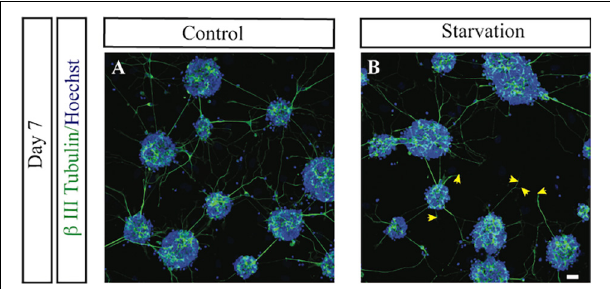
FIGURE 2 | The impact of exposure to starvation for glucose on neurite outgrowth in embryonic retinal cells. Representative confocal LSM images of untreated (control) (A) and starved primary retinal cells (B) on day 7 of the experiment described in this figure, showing neurons ( β III tubulin) and cell nuclei (Hoechst). The images are representative of 3–4 replicates. Scale bar, 20 µ m. n = 3–4. Arrows indicate loss of neurite outgrowth.